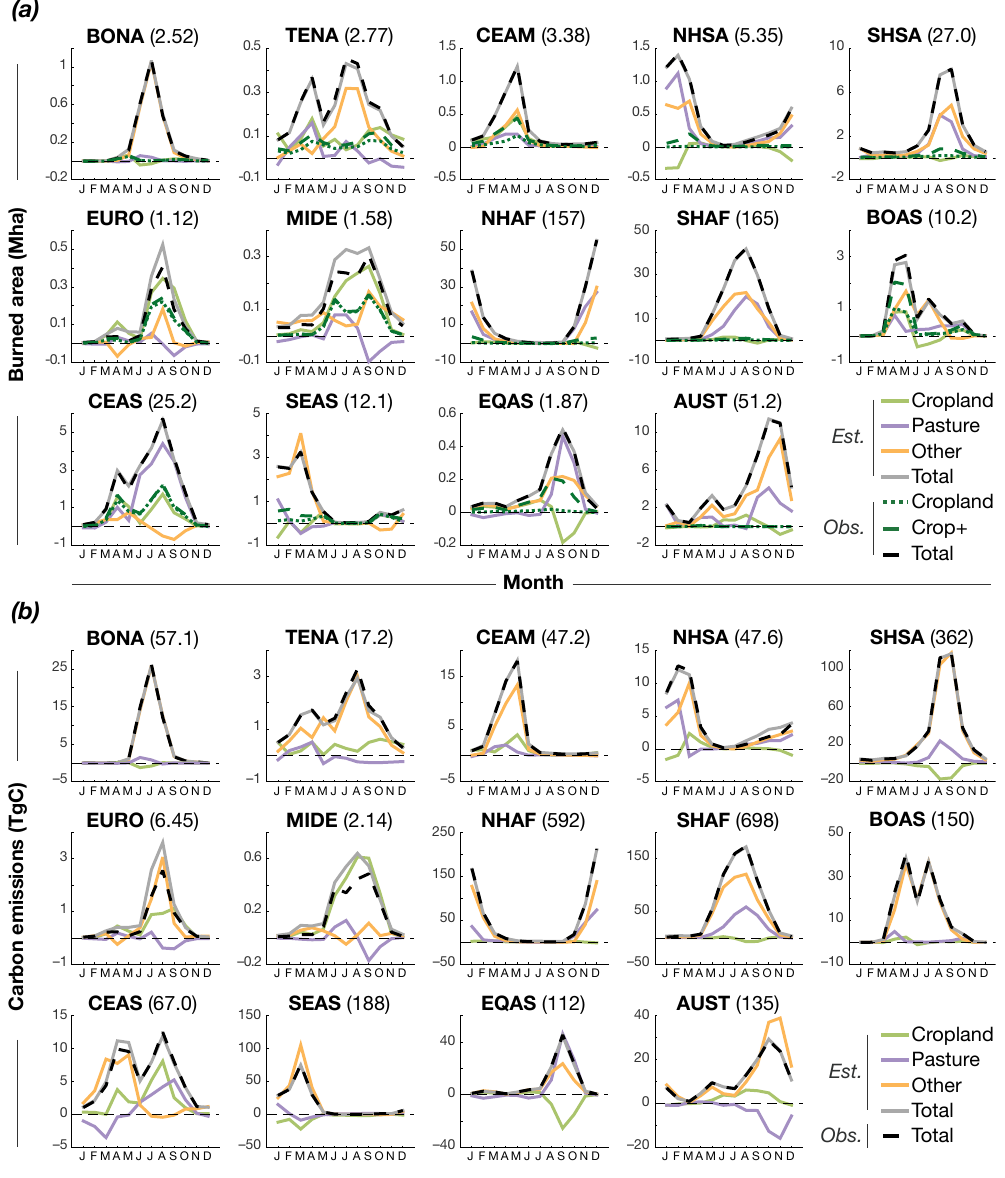
Figure 6. Seasonality of different fire types in each GFED region based on analysis of burned area ( a ; Mha) and C emissions ( b ; TgC). Numbers in parentheses next to region names represent mean annual observed fire there (either burned area or C emissions). Corresponds to Fig. S7. Data available in the